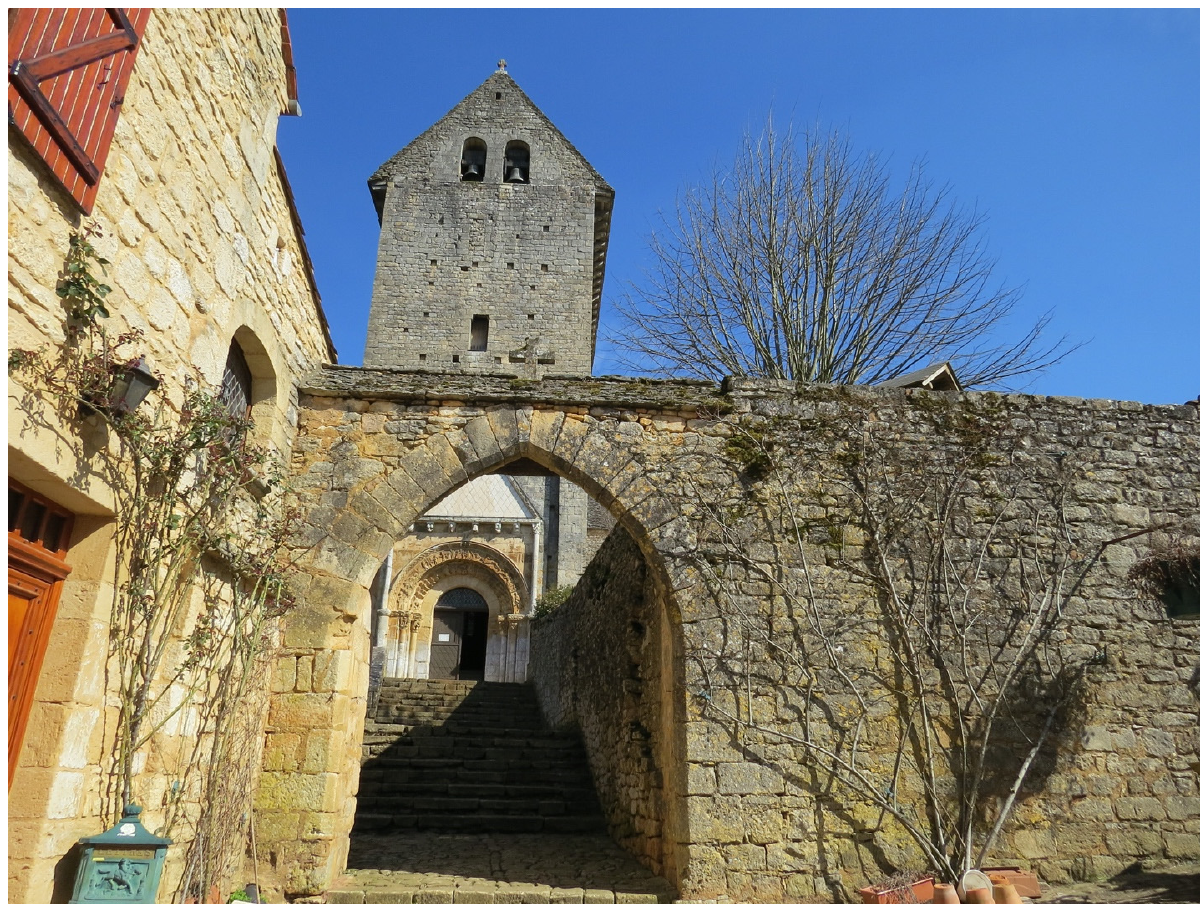
Figure 1. Saint-Martin Church , west façade, 12th c., Besse, Dordogne, Nouvelle-Aquitaine, France. ©Author.